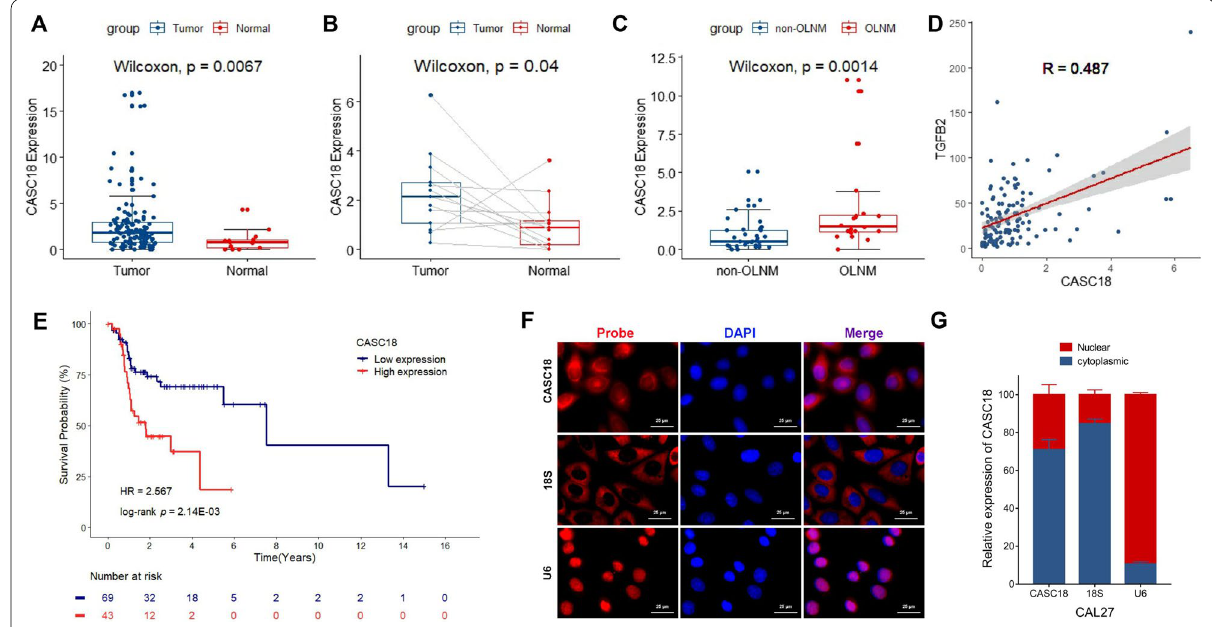
Fig. 4 The expression pattern and clinical characteristics of CASC18 in TCGA-TSCC cohort and CAL27 CASC18 is highly expressed in tumors as compared with A the normal tissues, B matched adjacent tissue in TCGA-TSCC cohort. CASC18 is C highly expressed in tumors derived from patients with OLNM as compared with those without OLNM, D positively correlated with TGFB2 expression, and E poor prognosis predictor. F The subcellular distribution of CASC18 was assessed by FISH staining in CAL27 cells, with the reference of 18 S and U6. G The abundance of CASC18 in nuclear and cytoplasmic RNA was determined and normalized against that of the internal control of 18 S and U6. Data are presented as mean SD, with a p-value < 0.05 considered statistically ±